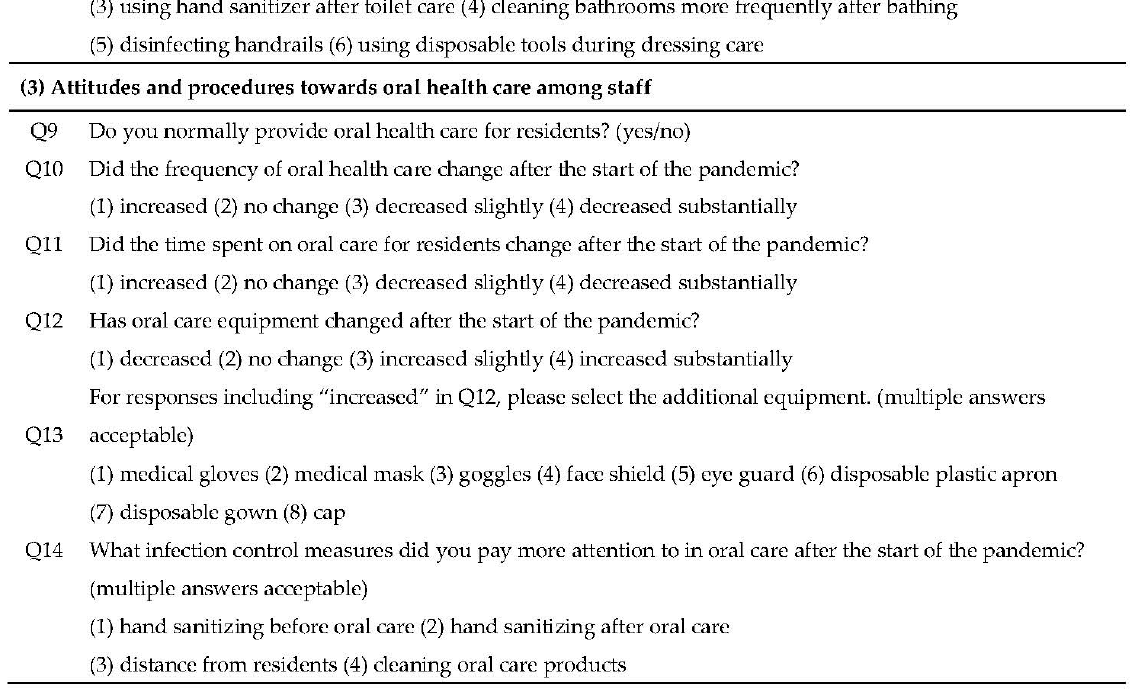
Figure 1. Questionnaire (translated from Japanese).